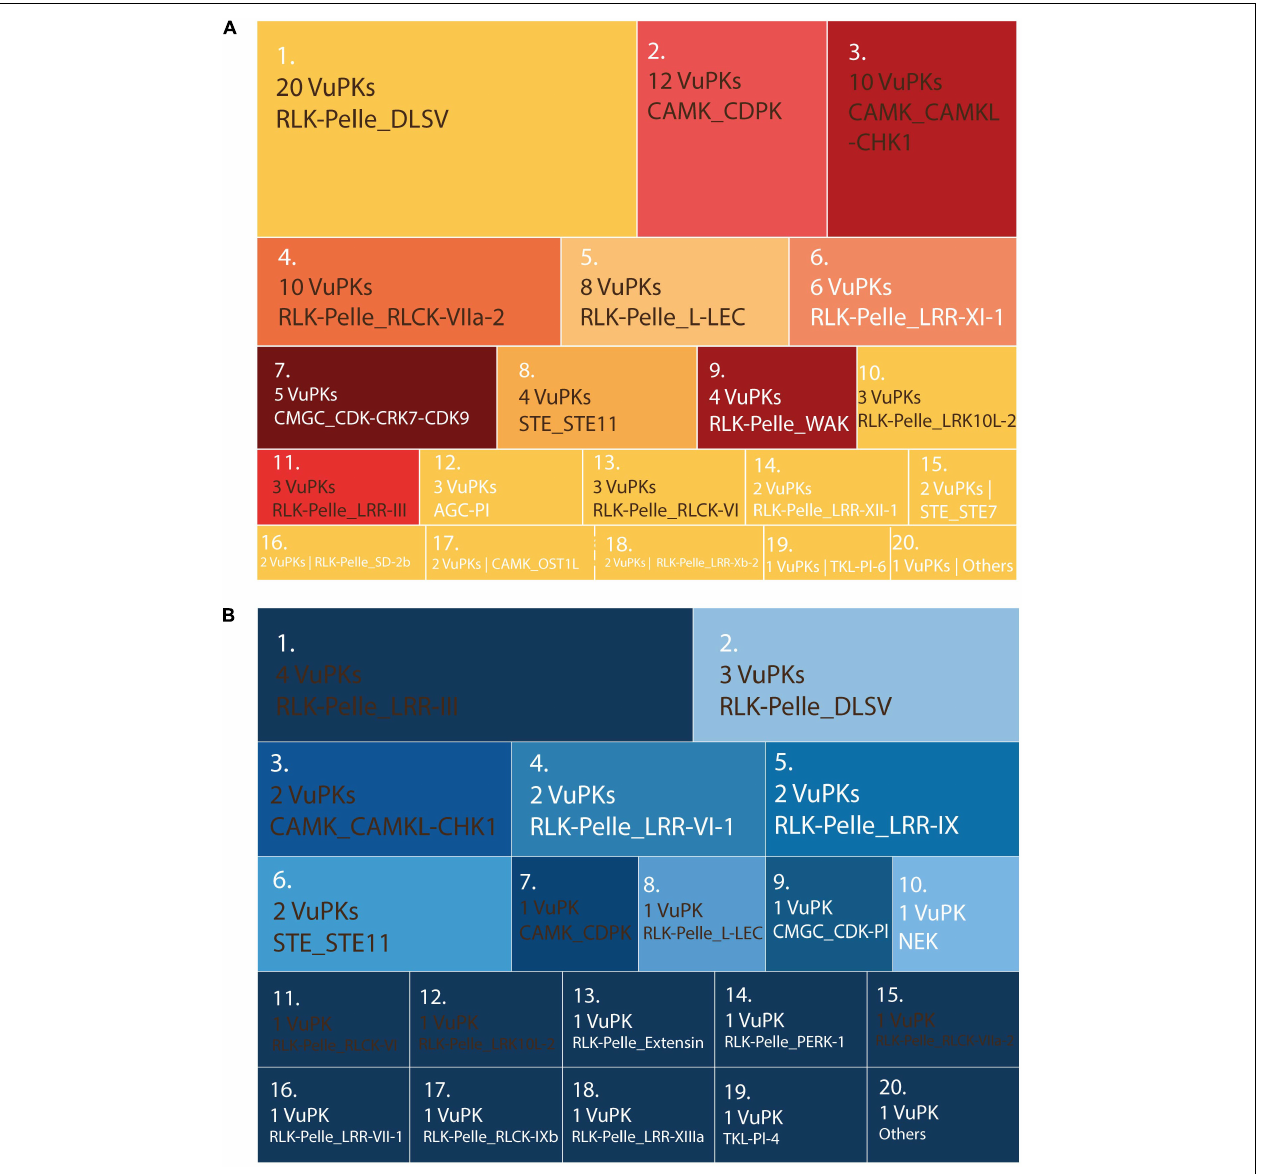
FIGURE 8 | Treemap containing the ranking of the 20 most up-regulated bona fide VuPK families on the treatments (60 min and/or 16 h) of the following assays: (A) mechanical injury + CABMV inoculation and (B) mechanical injury + CPSMV inoculation. Families highlighted in brown occur in (A) and (B) —differences in quantities indicate differences in the VuPKs that make up the sets. Families highlighted in white occur only in (A) or only in (B) . VuPKs, V. unguiculata protein kinases; CABMV, cowpea aphid-borne mosaic virus; CPSMV, cowpea severe mosaic virus; others in (A) (25 families with one up-regulated VuPK each); others in (B) (four families with one up-regulated VuPK